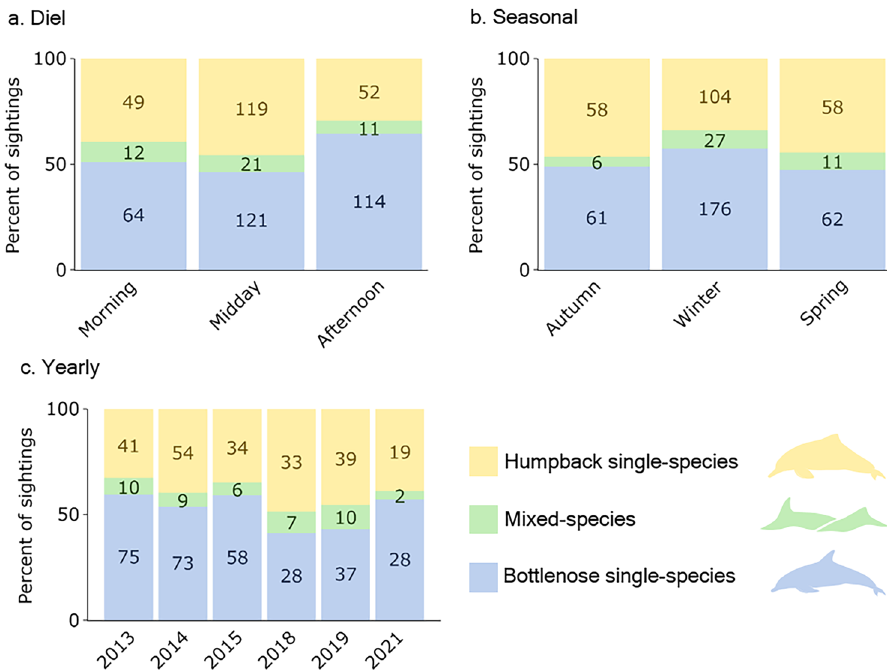
Figure 5. The percentage of on-effort sightings that were of only Australian humpback dolphins ( Sousa sahulensis ), only Indo-Pacific bottlenose dolphins ( Tursiops aduncus ), and mixed-species sightings containing both species across three temporal scales—( a ) diel: morning (0600 to 1000 h), midday (1000 to 1400 h), and afternoon (1400 to 1900 h); ( b ) seasonal: autumn (March—May), winter (June—August), and spring (September—November); and ( c ) yearly. Numbers in the bars are the total number of sightings for each sighting category in that temporal